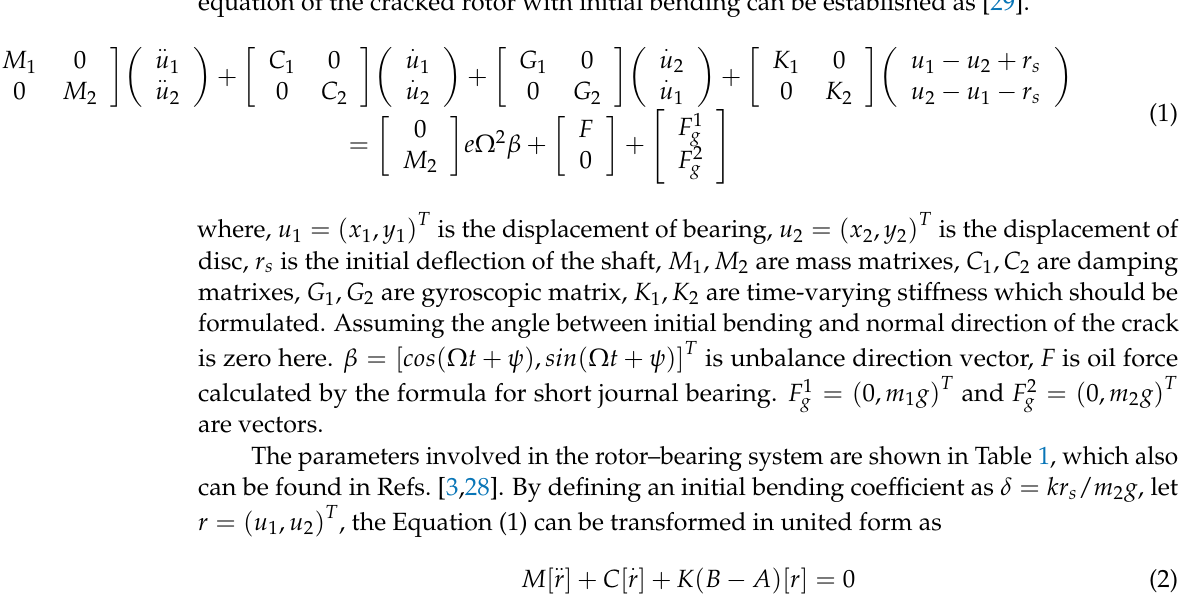
Figure 1. A cracked bearing-rotor system. ( a ) structure schematic, ( b ) cracked cross-section geometry. Neglecting torsional vibration, only lateral vibration is considered and the vibration equation of the cracked rotor with initial bending can be established as